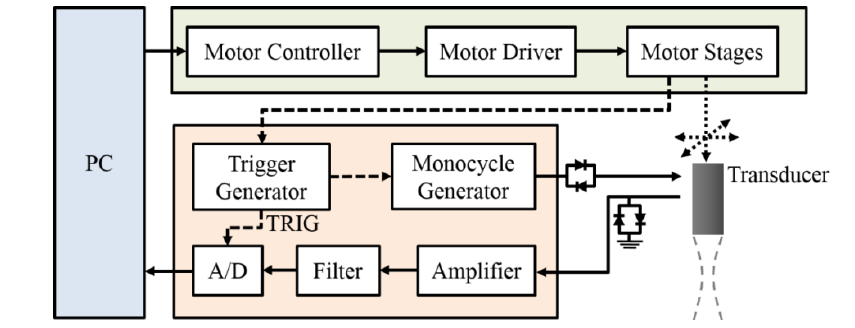
Figure 2. Schematic diagram of the high-frequency ultrasound system.